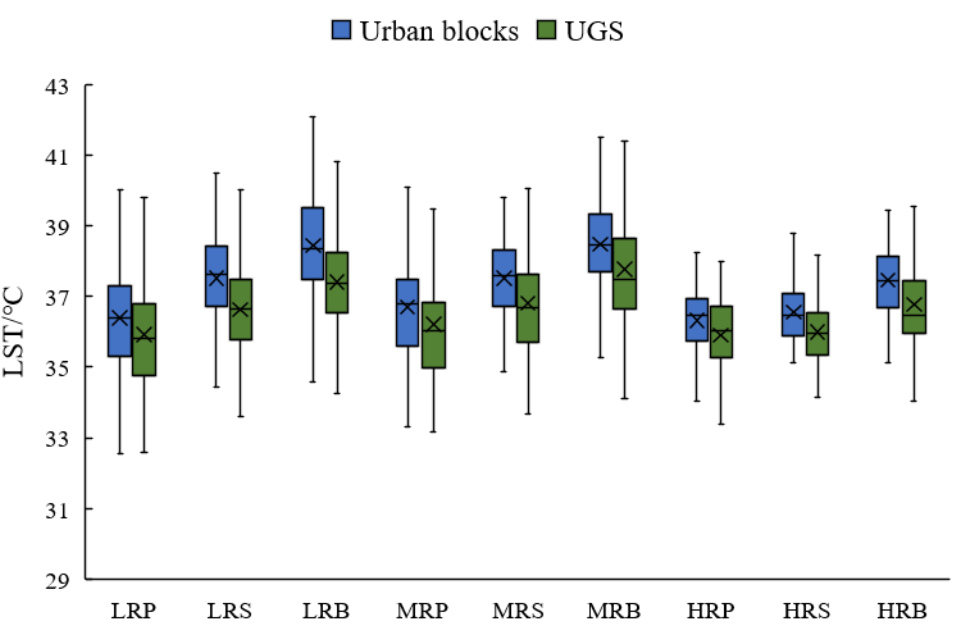
Figure 6. Comparison of LST between urban blocks and UGS.